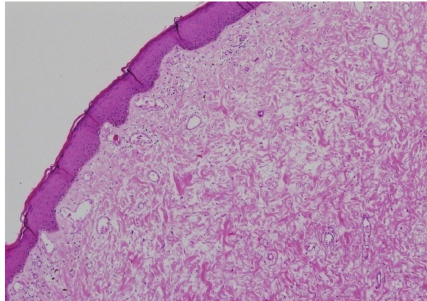
Figure 4: Fibroepithelial stromal polyp with a hypercellular and focalmyxoidstromaandvascularstructures(hematoxylinandeosin stain, magnification ×